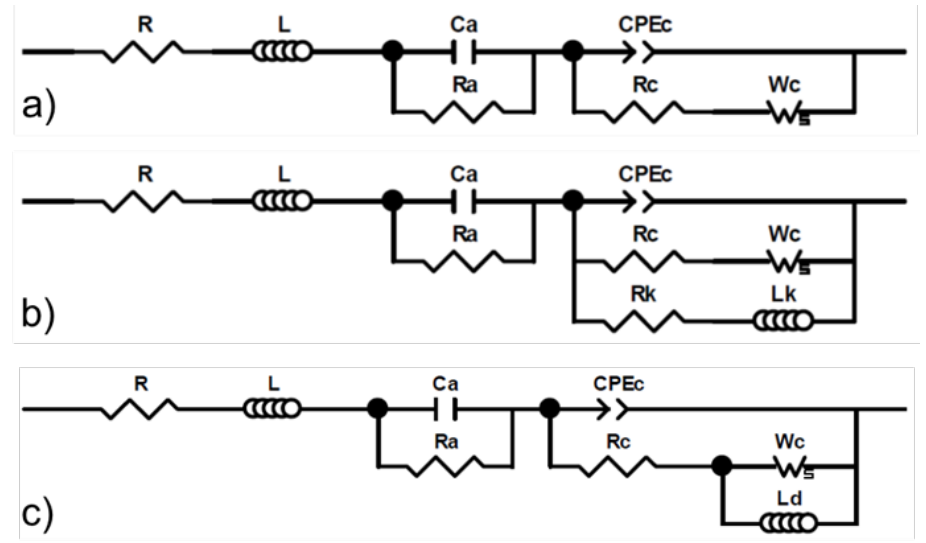
Figure 3. Equivalent circuit models for a proton exchange membrane fuel cell (PEMFC). ( a ) The model previously derived for SO 2 contamination and used for all 7 organic contaminants investigated in this work; ( b ) the model previously derived to capture low-frequency inductive data in the absence of contaminants and used to fit data during acetonitrile contamination (0.1 mg Pt cm − 2 ); ( c ) the modified model ( b ) to capture low-frequency inductive data obtained during acetonitrile (0.4 mg Pt cm − 2 ) and propene (0.1 mg Pt cm − 2 ) contamination.